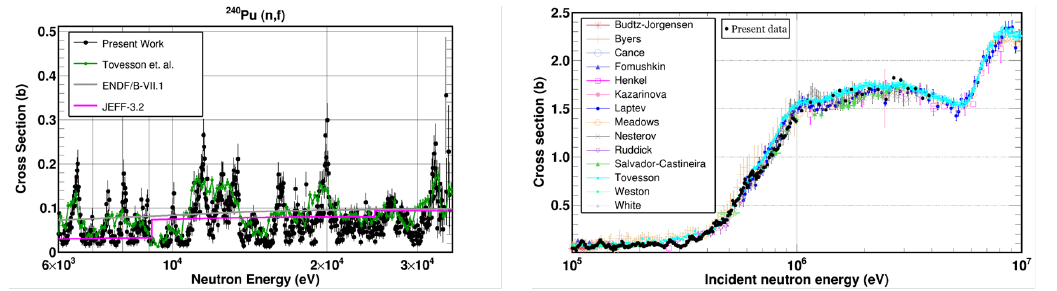
Figure 5: 240 Pu(n,f) cross section in the resonance region (left hand side), and in threshold region (right hand side)